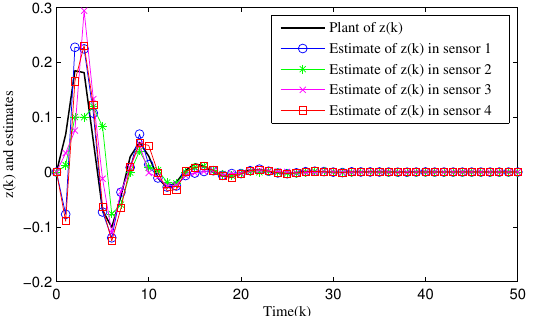
Figure 6. Evolution of full-order filtering ˆ z i ( k ) , i = 1,2,3,4.